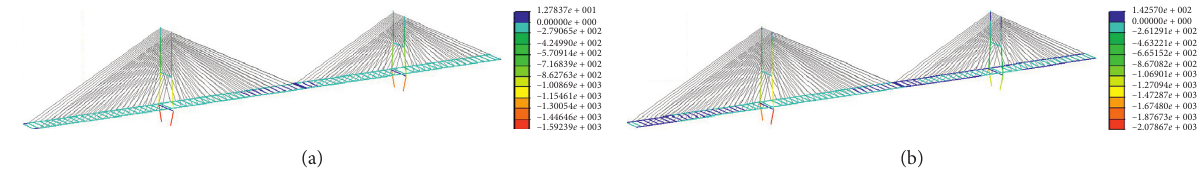
Figure 10: Stress distributions on pylons and the main girder for (a) intact case and (b) damaged case (unit: tonf/m 2 ).